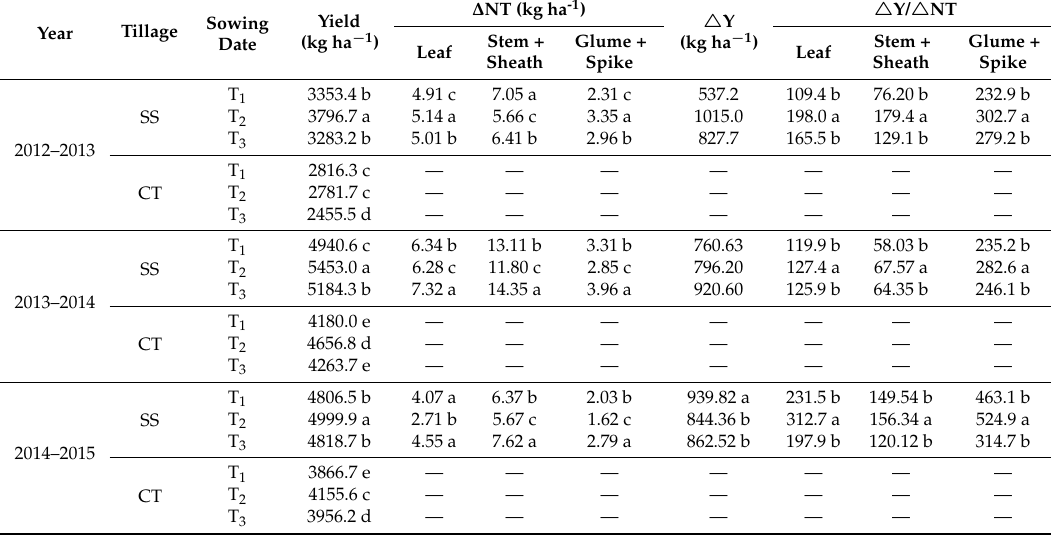
Table 5. Effect of subsoiling at different sowing dates on the contribution of N translocation before anthesis on